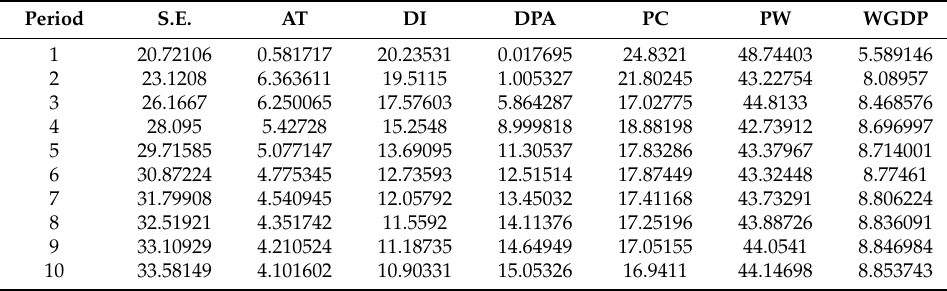
Table 8. Variance decomposition of WGDP (%).